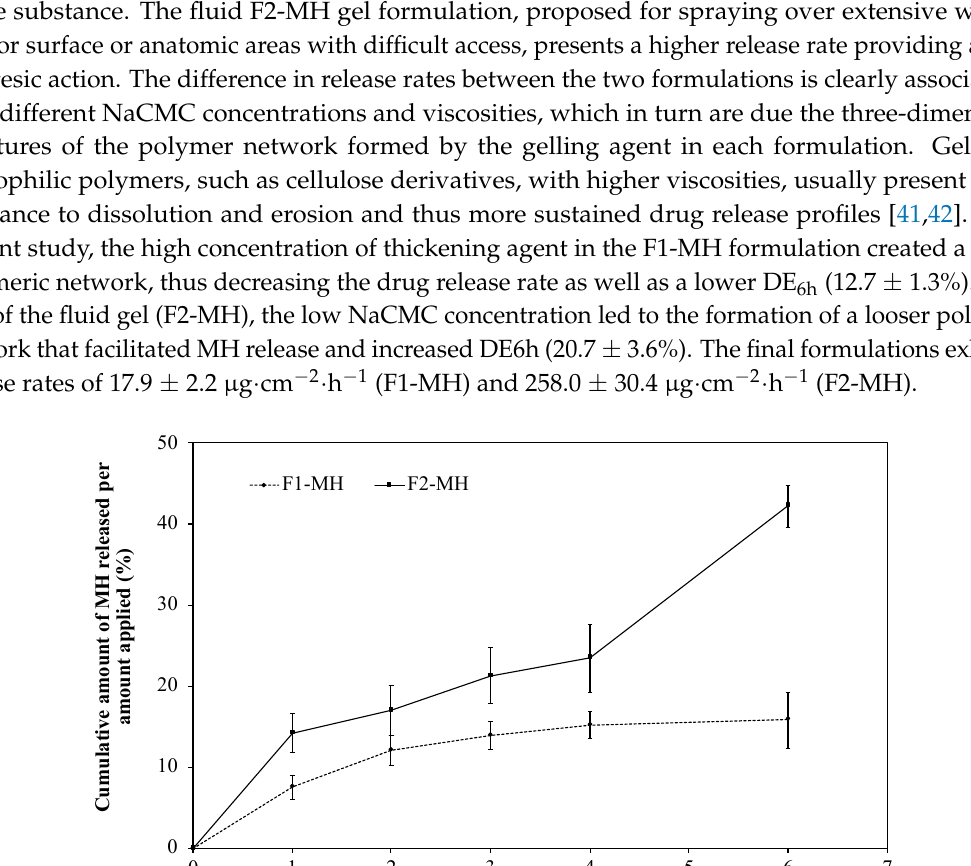
Table 3. Main characteristics of the NaCMC semi-solid (F1-MH) and fluid (F2-MH) morphine- containing hydrogels (mean ± SD, n = 3).